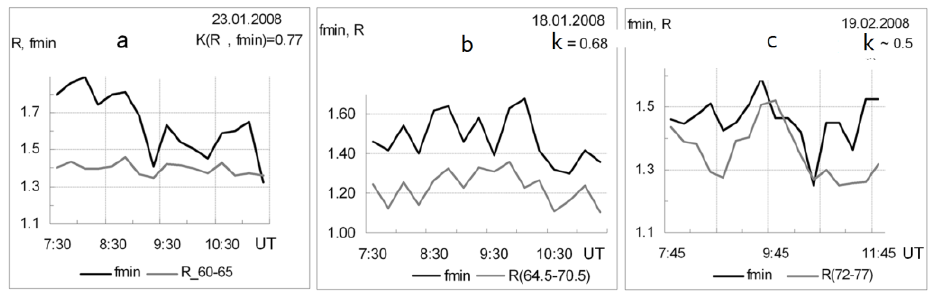
Fig. 6. Correlation of the ionospheric parameter fmin with the scattering ratio R in the